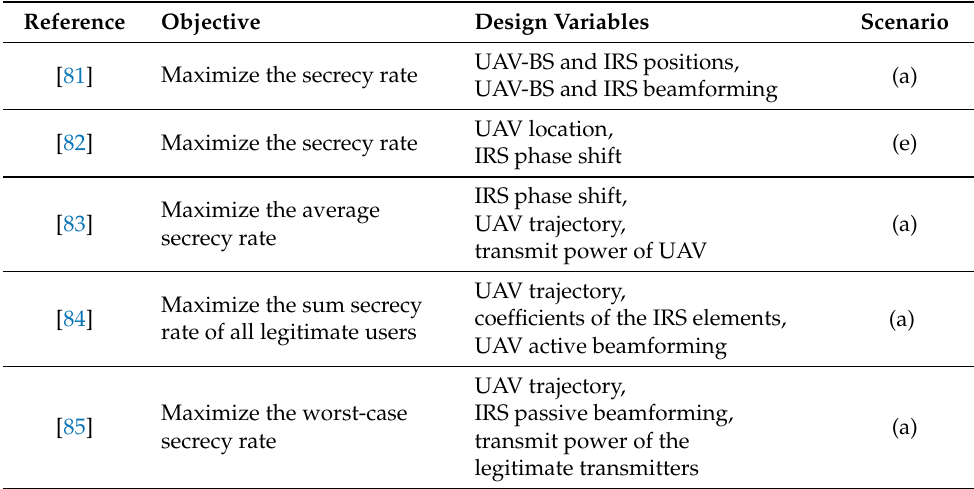
Table 3. Summary of previous works relevant to improvement of